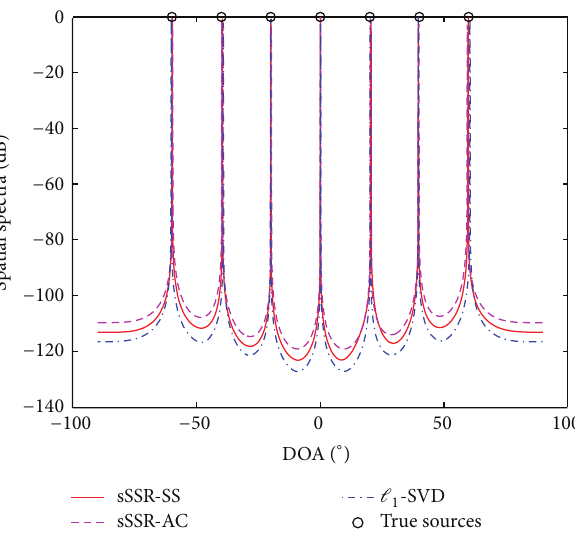
Figure 4: Spatial spectra for 𝑀 − 1 sources with SNR = −5